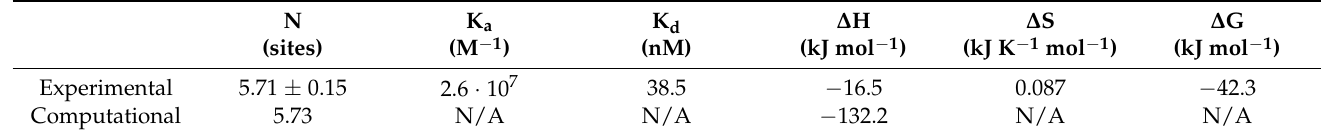
Table 1. Summary of the energetics parameters involved in the molecular